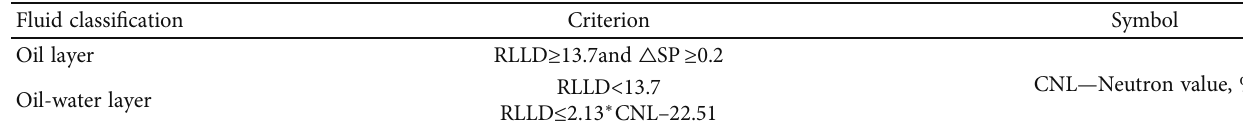
Table 3: Discrimination standard table.